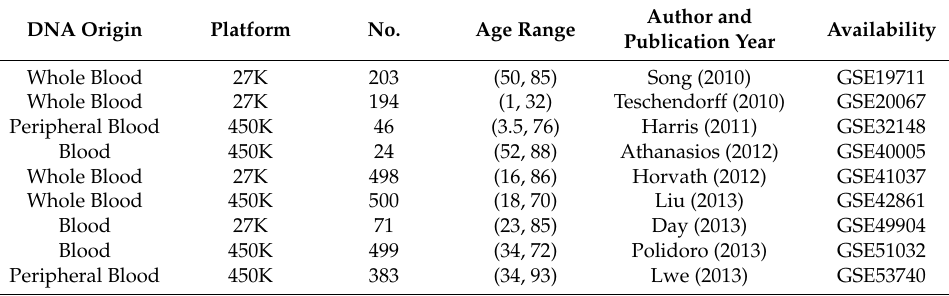
Table 2. Nine disease DNA-methylation